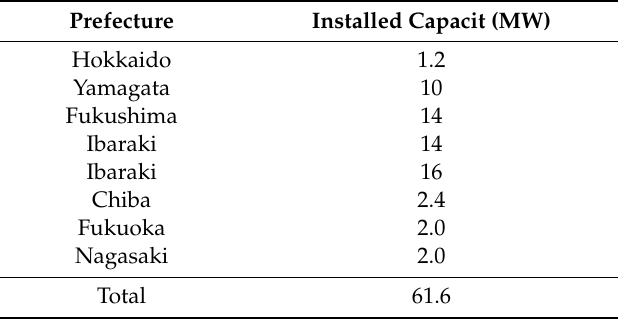
Table 2. Overview of Japanese o ff shore wind projects